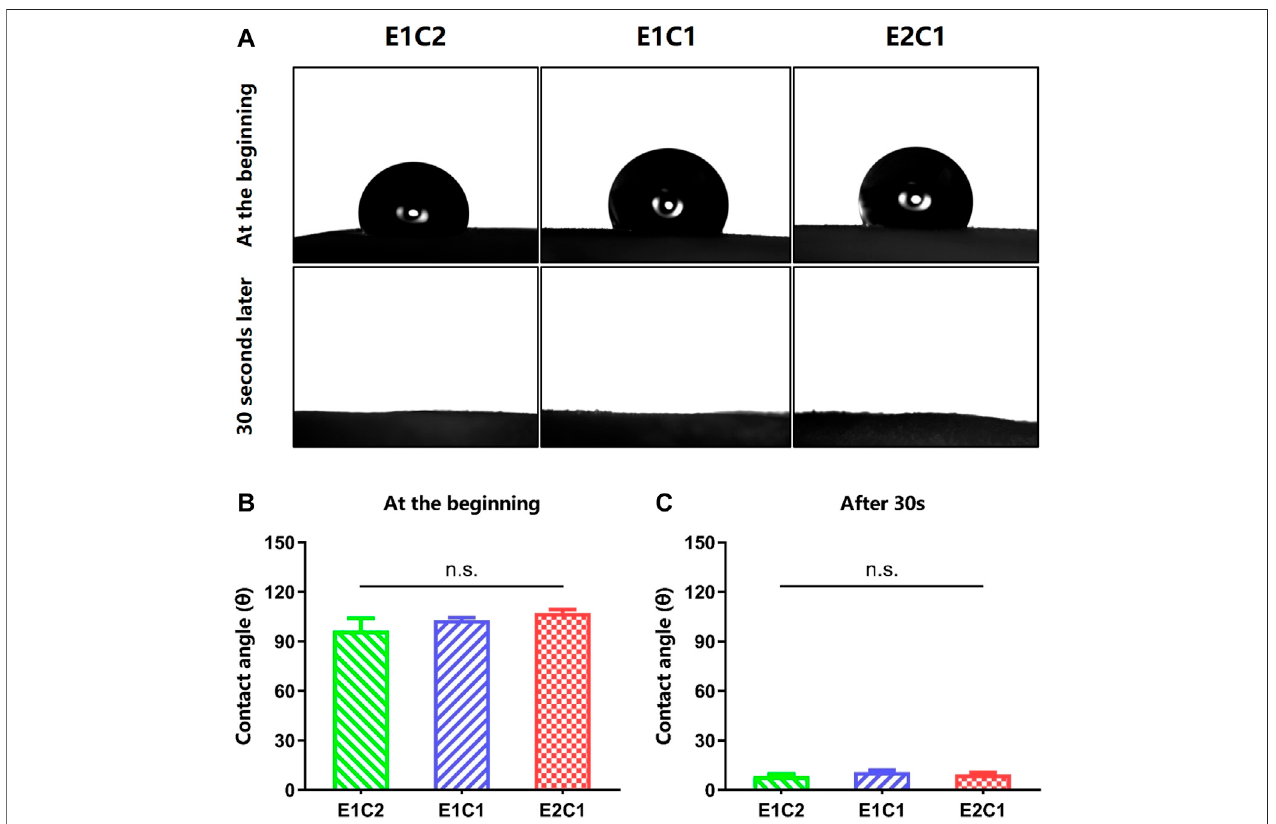
FIGURE 7 | Contact angle of the scaffolds. (A) The pictures of the contact angle at the beginning and 30 s later. (B) The statistical result ofthe contact angle at the beginning. (C) The statistical result of the contact angle 30 s later. n.s.: p > 0.05.